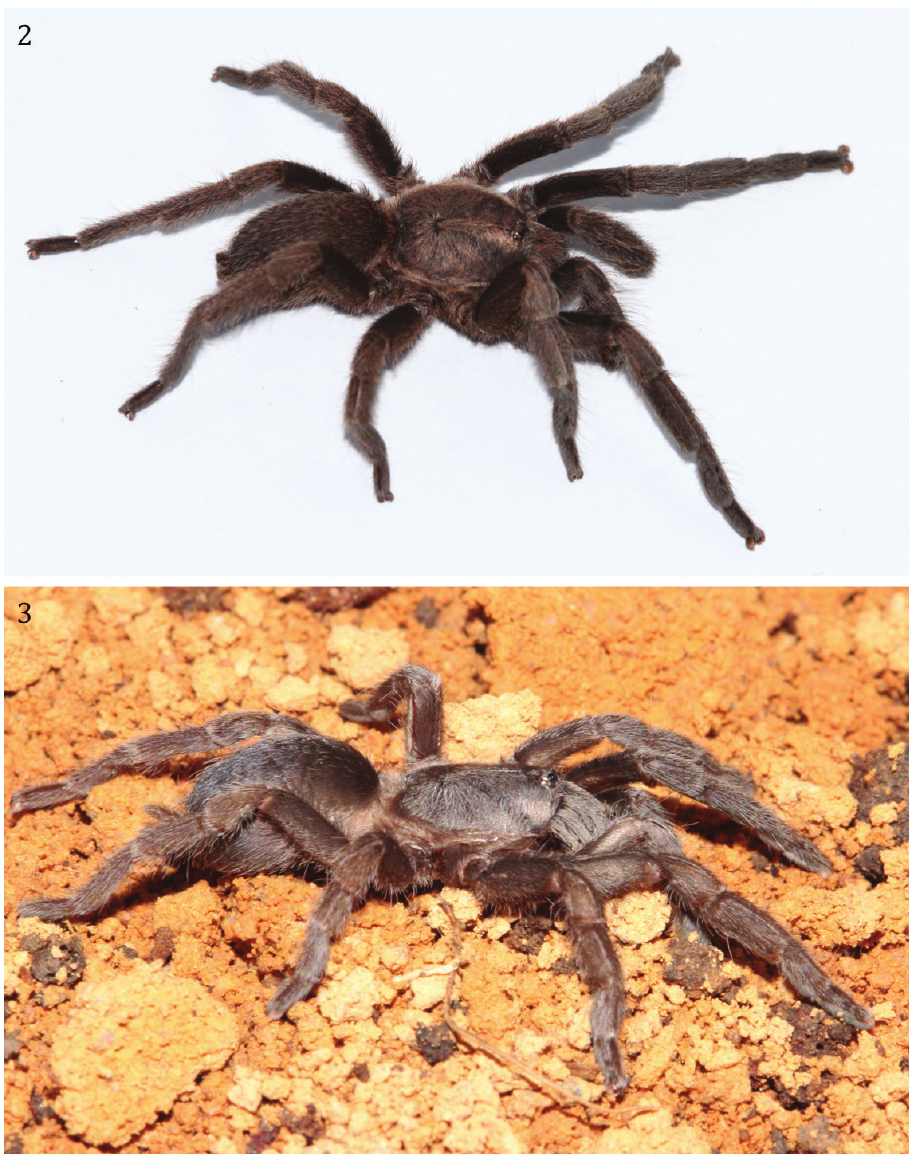
Figures 2–3. Phlogiellus longipalpus sp. n. 2 paratype ♂ , CUMZ-C3-NA2 3 paratype ♀ , CUMZ-C4-NA4.